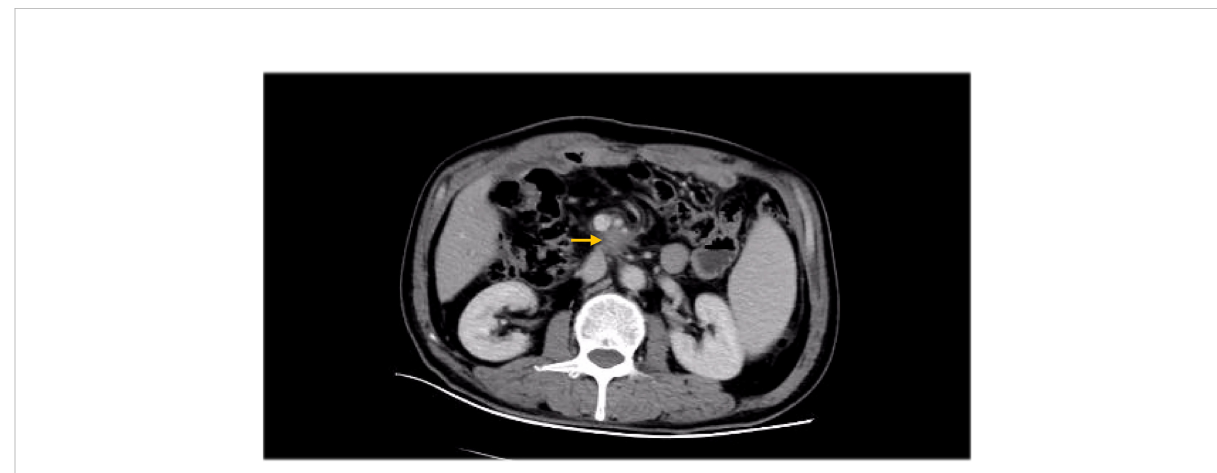
FIGURE 7 CT Before radiotherapy (abdominal metastatic lymph nodes).